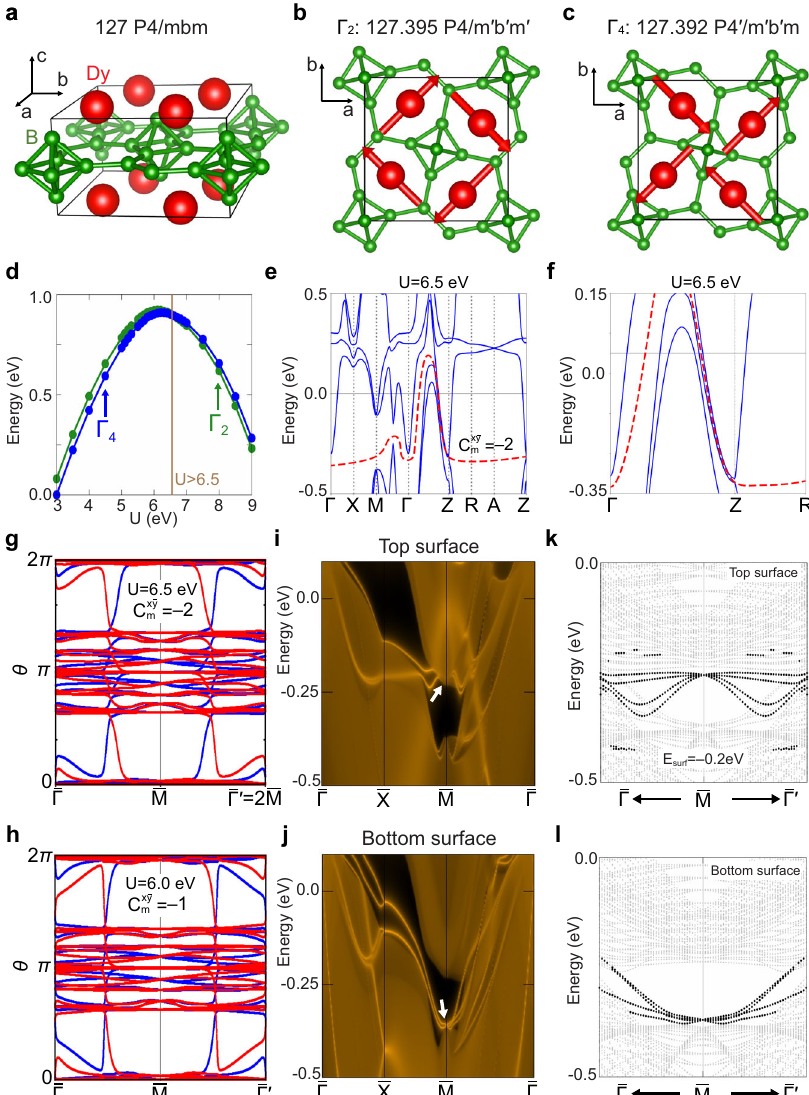
Fig. 3 DyB 4 , a Type-III TMDI candidate. a Tetragonal crystal structure of DyB 4 . b , c Magnetic spin structures in the b Γ 2 and c Γ 4 states. The Γ 4 state corresponds to Type-III MSG 127.392 P 4 0 = m 0 b 0 m with (001)-surface MWG p 4 0 g 0 m . d Density functional theory (DFT) total energy differences between the Γ 4 and Γ 2 states. The absolute values are adjusted to be in the range between 0 eV and 1 eV. The magnetic phase transition is indicated by the brown solid line. The Γ 4 state has lower energy than the Γ 2 state when U ≤ 6.5 eV. e , f Bulk band structure from DFT + U calculations ( U = 6.5 eV and J = 1 eV) for the Γ 4 state. The band gap near the Fermi level is indicated by the red dashed lines. g , h Wilson loop spectra below the red dashed line along Γ - M - Γ 0 . The winding structure exhibits g C xy U = 6.0 eV. i , j (001)-surface spectra for the i top (B-terminated) and j bottom (Dy-terminated) surfaces obtained using the surface Green ’ s function method. The white arrows guide where surface states appear. k , l (001)-surface band structures from a 60-layer slab calculation, which are drawn to show surface states indicated by the white arrows in i , j . Bulk and surface bands are represented by gray and black, respectively. Surface Dirac fermions are moved inside the gap by applying a surface potential of − 0.2 eV on the top. i – l are calculated using the Wannierized tight-binding model from the DFT + U calculation ( U = 6.5